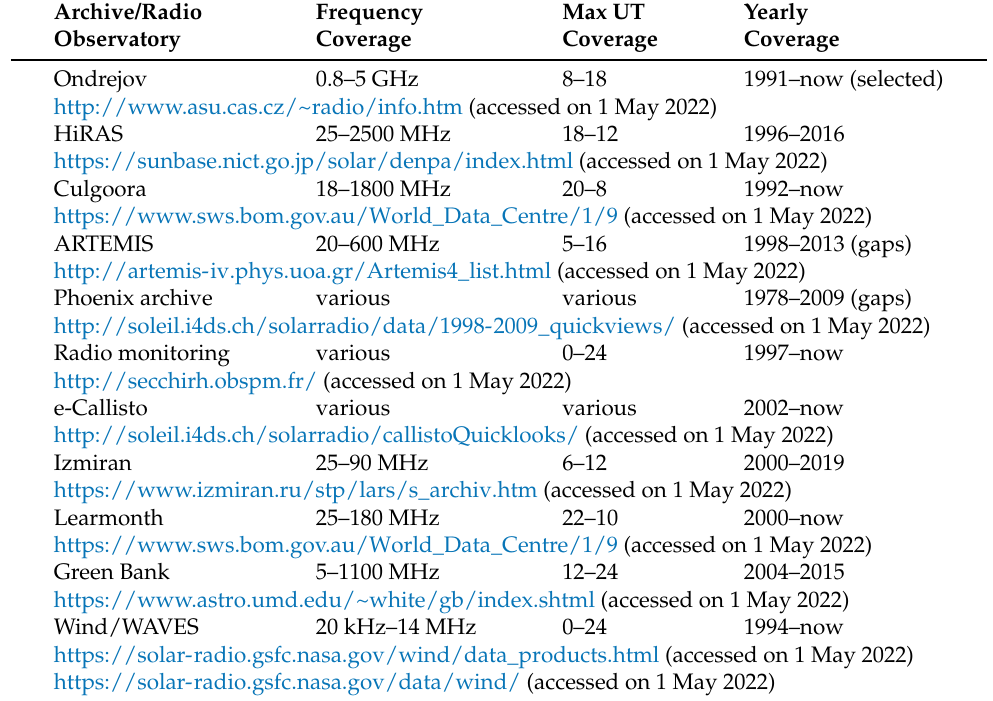
Table 1. A list with radio observatories, ground-based and space-borne used in the analysis.